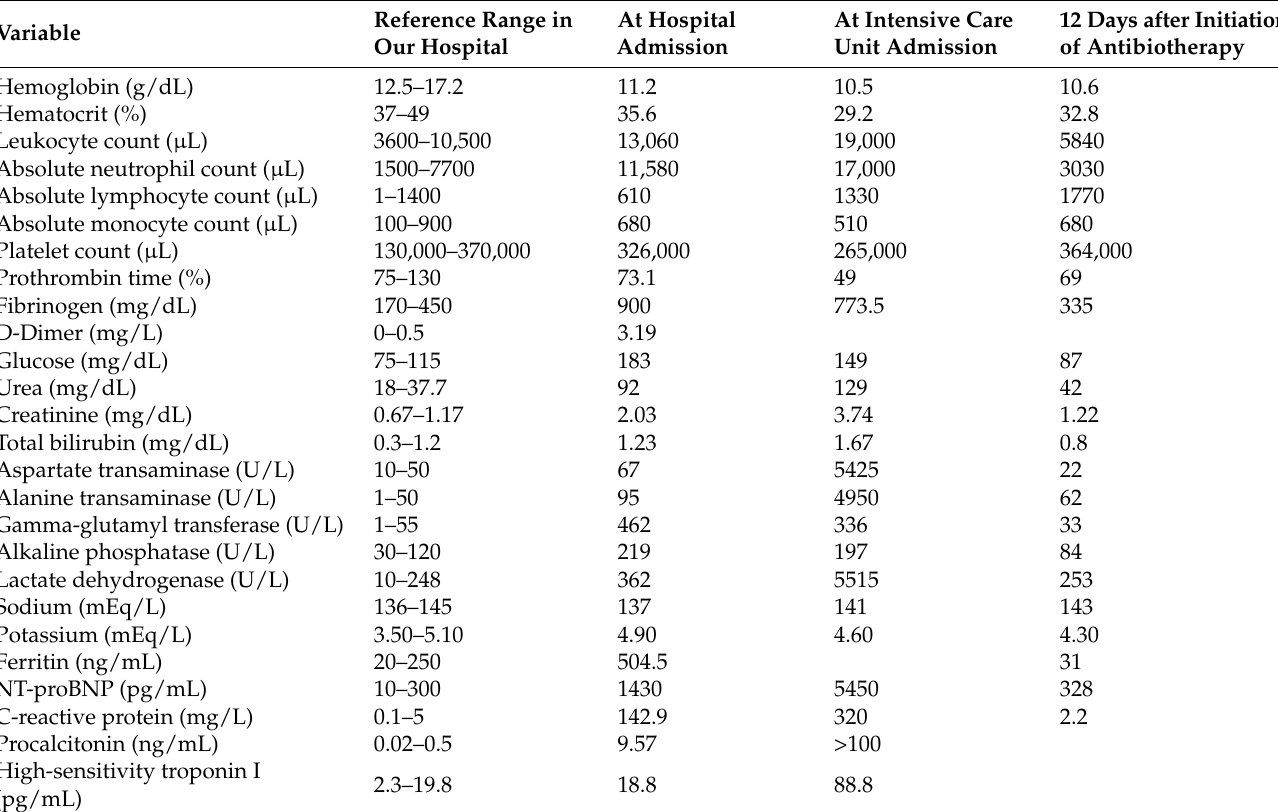
Table 1. Patient analytics at infection onset and after 12 days of antibiotic